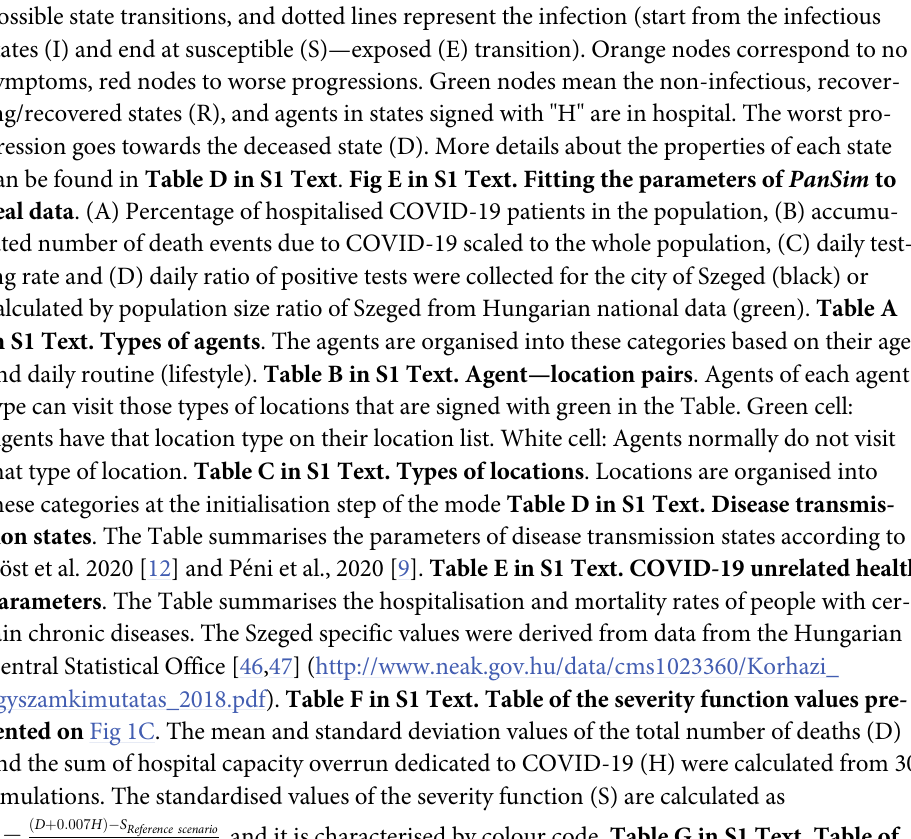
, and it is characterised by colour code. Table G in S1 Text. Table of performance scalability with increasing agent counts